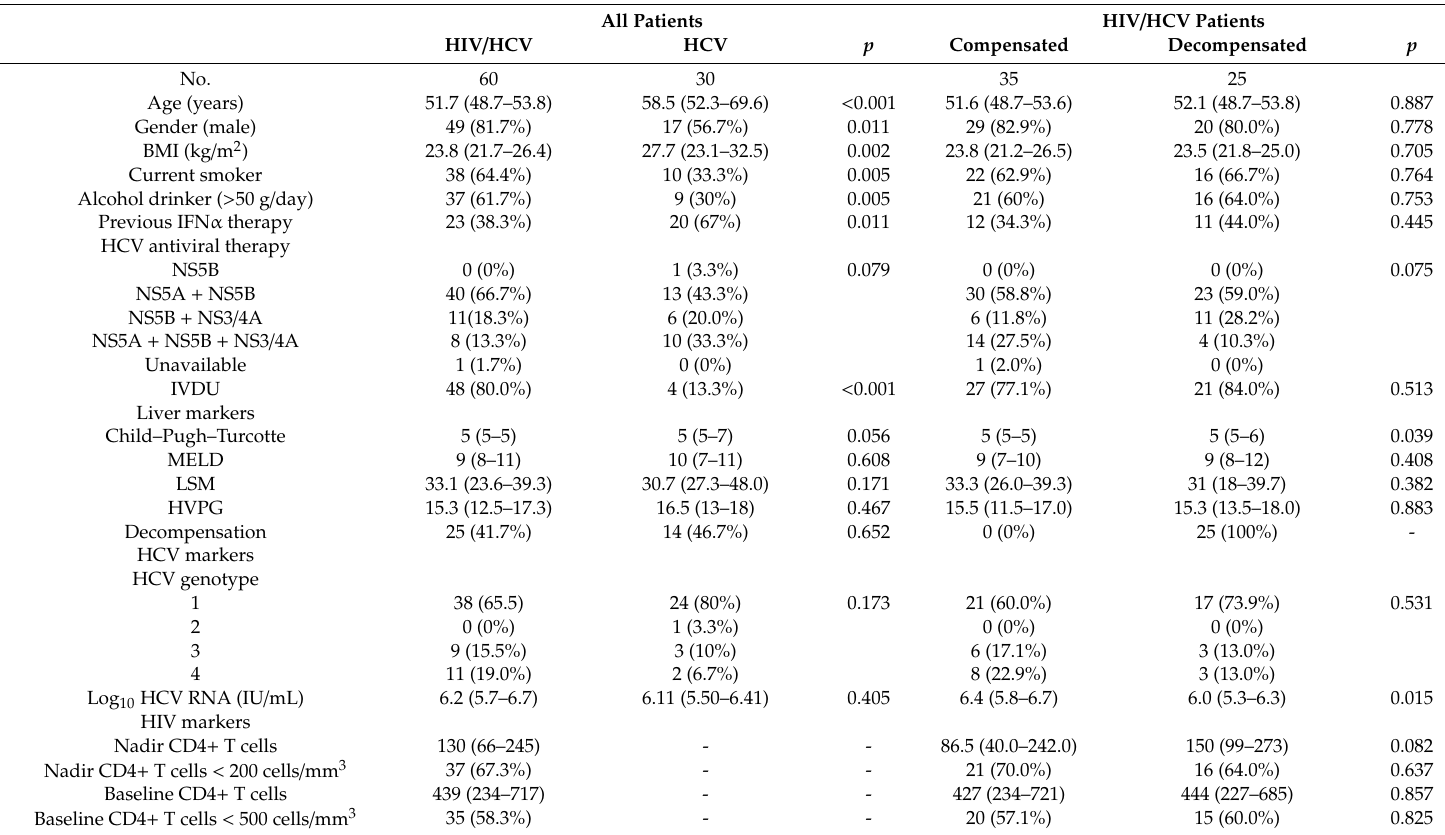
Table 1. Clinical and epidemiological characteristics of patients with advanced HCV-related cirrhosis, stratified by HIV